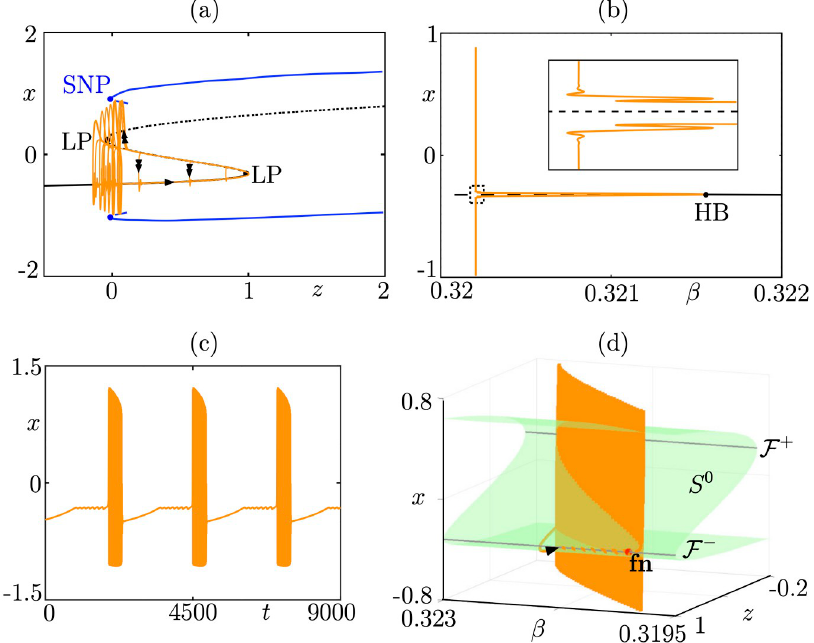
Fig 10. Folded-node/fold-of-cycles bursting. Panels (a-b) show the spike-adding transition in system (1): (a) in the ( z , x ) plane where we show several limit cycles for β -values exponentially close to 0.320207 superimposed onto the fast subsystem bifurcation diagram; (b) bifurcation diagram of the associated 3D bursting system (1) with respect to parameter β , showing the sharp rise of the amplitude of the limit cycle branch (orange), corresponding to spike-adding transitions. Panels (c-d) show a folded-node/fold-of-cycles bursting orbit in the extended 4D system (6): (c) in the ( β , z , x ) space (single/double arrows indicate slow/fast motion); (d) time course of the fast variable x . Equations and parameter values are given in S1 Text.